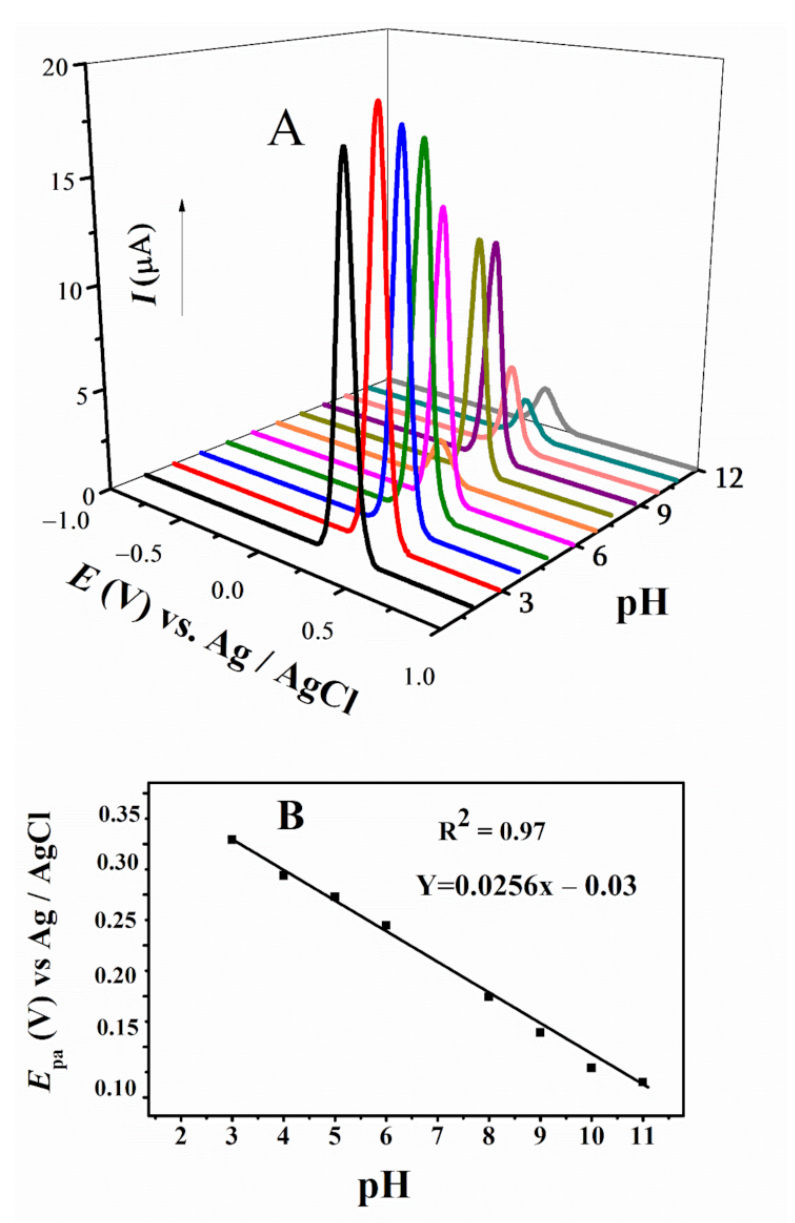
Figure 5. ( A ) DPV of FBA obtained at 0.1 V/s in different pH media and ( B ) plot of E pa vs. pH of